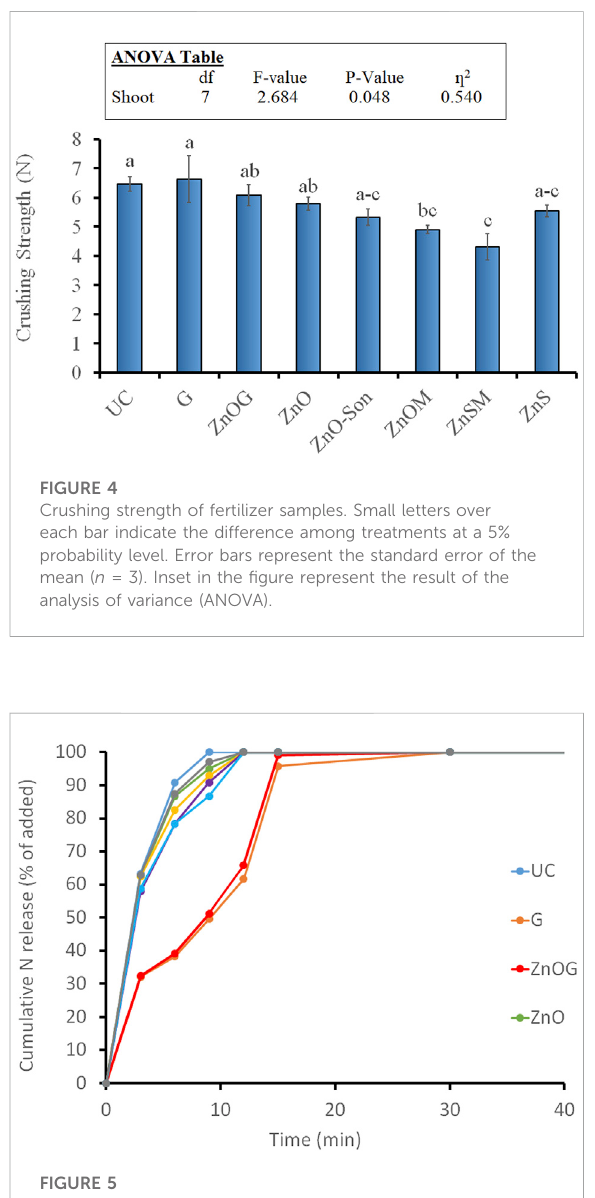
FIGURE 5 Release pro fi le of coated samples, namely, UC, G, ZnOG, ZnO, ZnO-Son, ZnOM, ZnSM, and